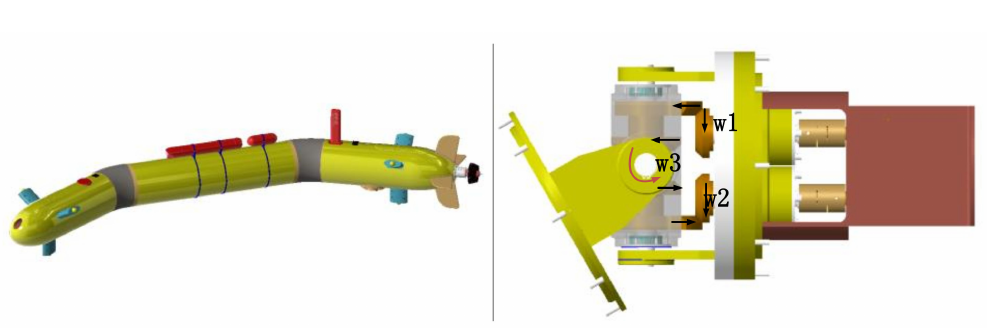
Figure 3. Orthogonal joint yaw